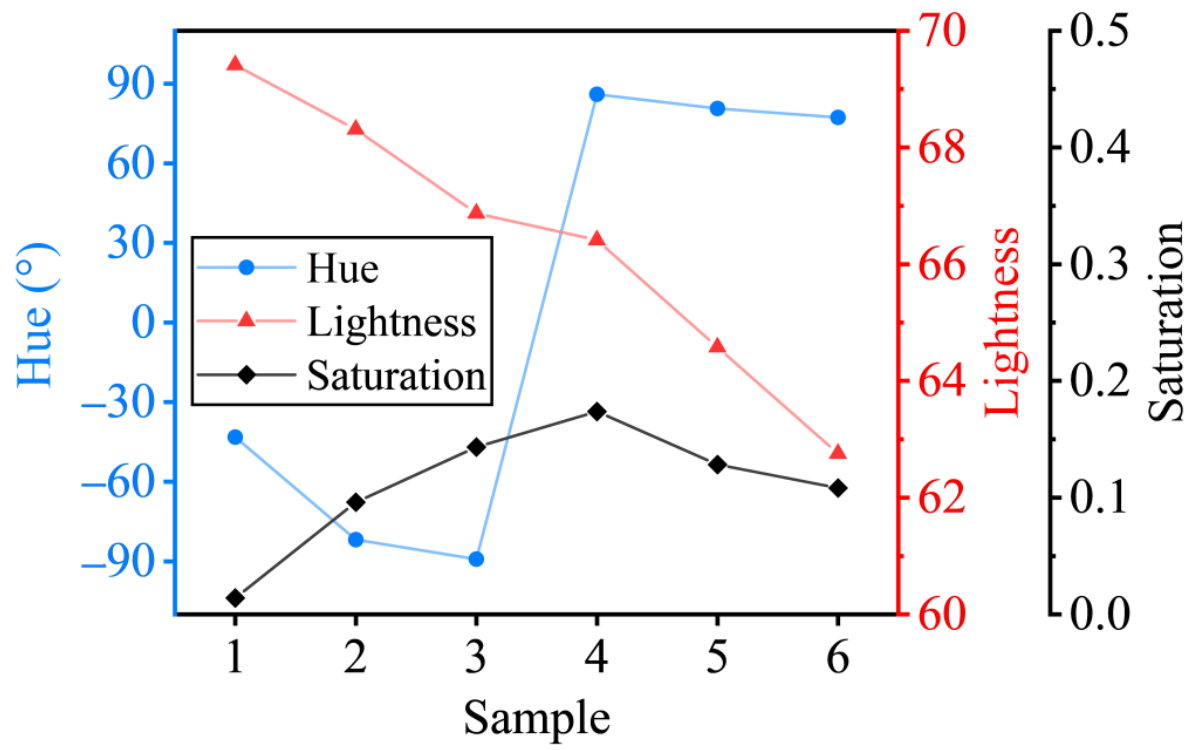
Figure 7. Hue, lightness and saturation of S1 – S6. Table 1. Colorimetric parameters of S1 – S6 with increasing the number of Lorentz oscillators.